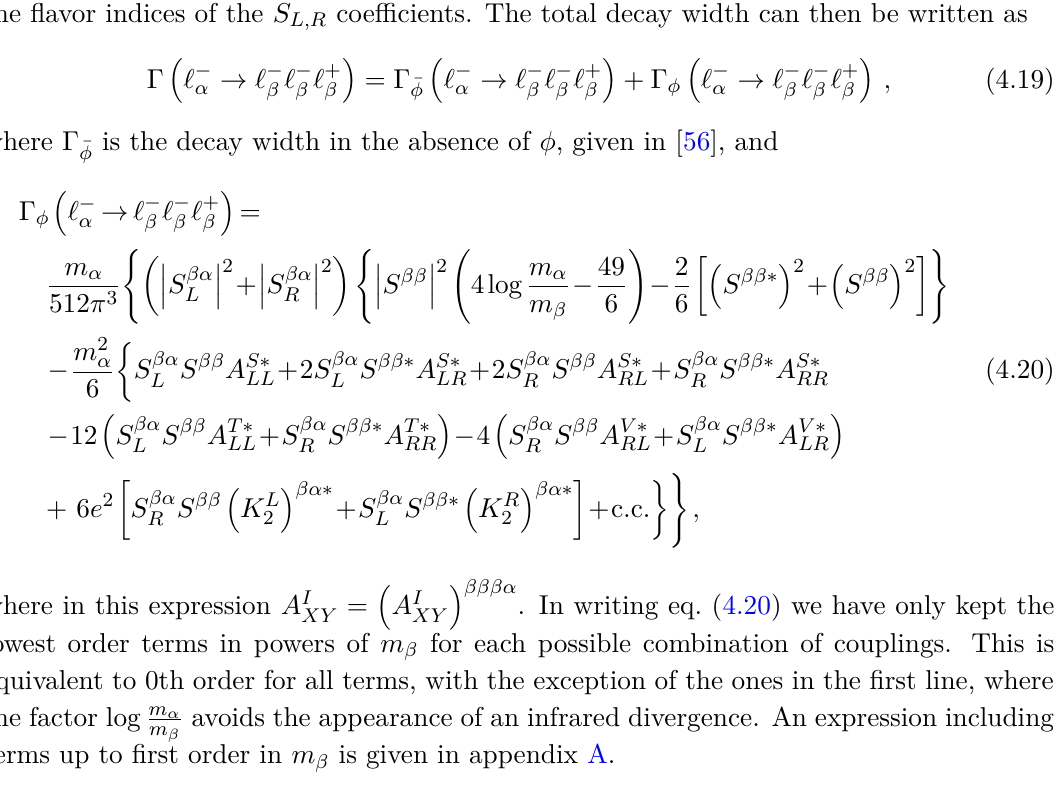
Figure 3 . Tree-level Feynman diagrams contributing to the process ‘ − the effective Lagrangian in eq.